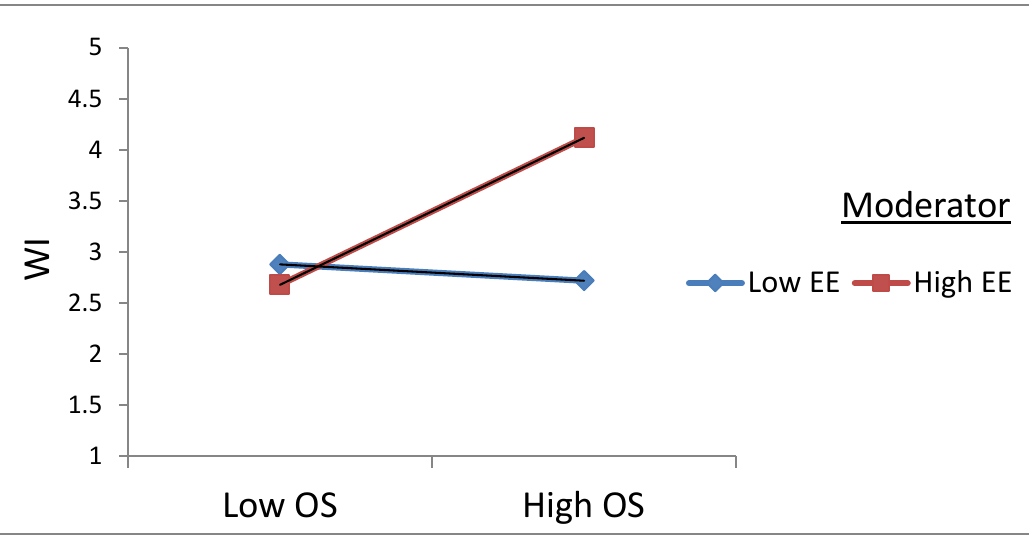
Figure 2. Interaction plot between organizational change and emotional exhaustion on workplace incivility.